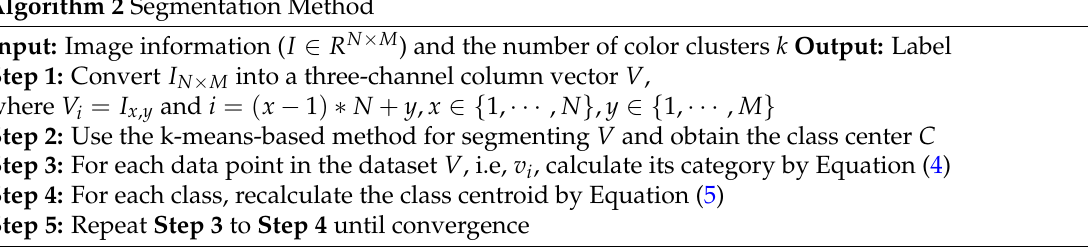
Algorithm 2 Segmentation